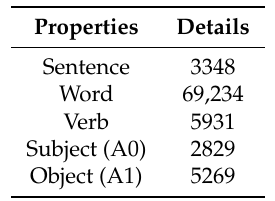
Table 5. Properties of Data set 1.